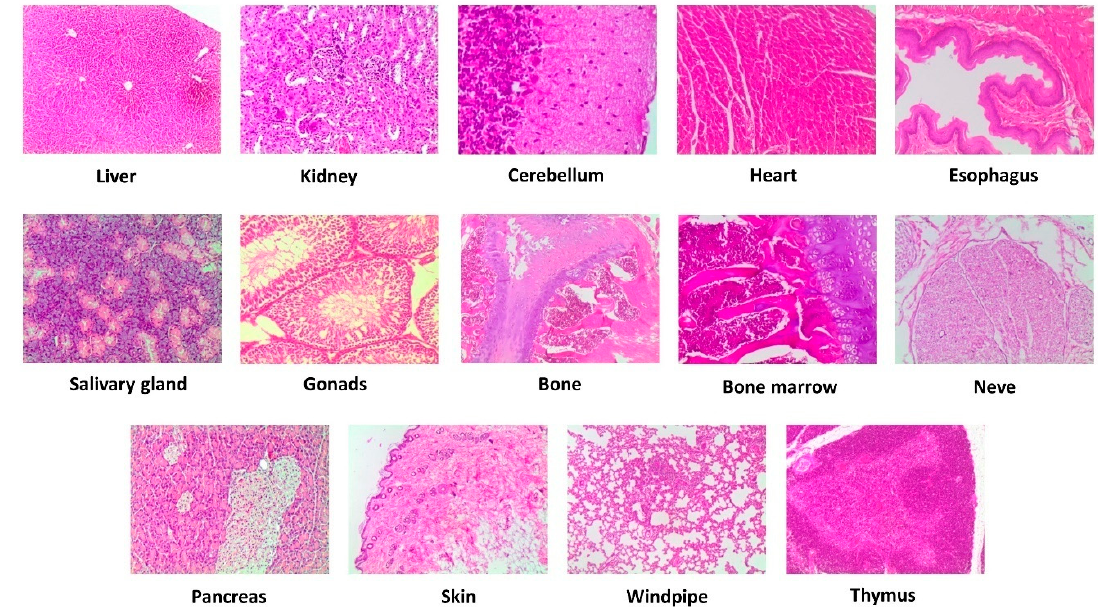
Figure 4. Representative microscopic evaluation (10×) of selected tissues after intervention with the high dose (1000 mg/kg/day) of a VOO extractin the study is sub chronic. Virgin olive oil, VOO.